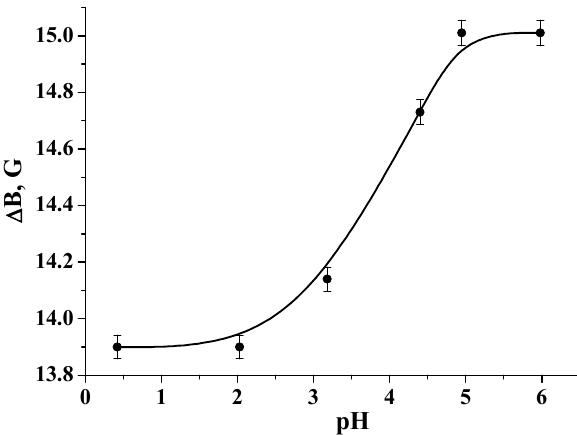
Figure 8. pH dependence of the distance between the central and left components ( Δ B) of the EPR spectra of DPI in water solution.